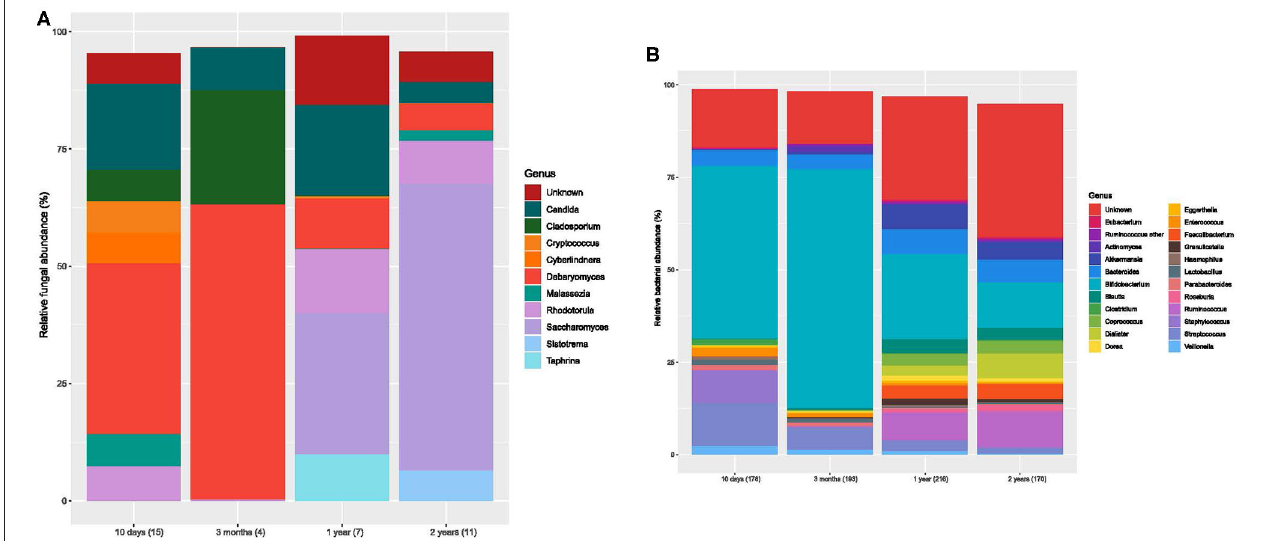
FIGURE 2 | Bar charts of fungal and bacterial gut communities. (A) Mean relative abundances for the fungal genera ( > 1% abundant) for each age group. Each color designates a genus. Number of samples for each bar is stated in brackets below the bar. (B) Mean relative abundances for the bacterial genera for each age group. Each color designates a genera. The number of samples is stated in brackets below the